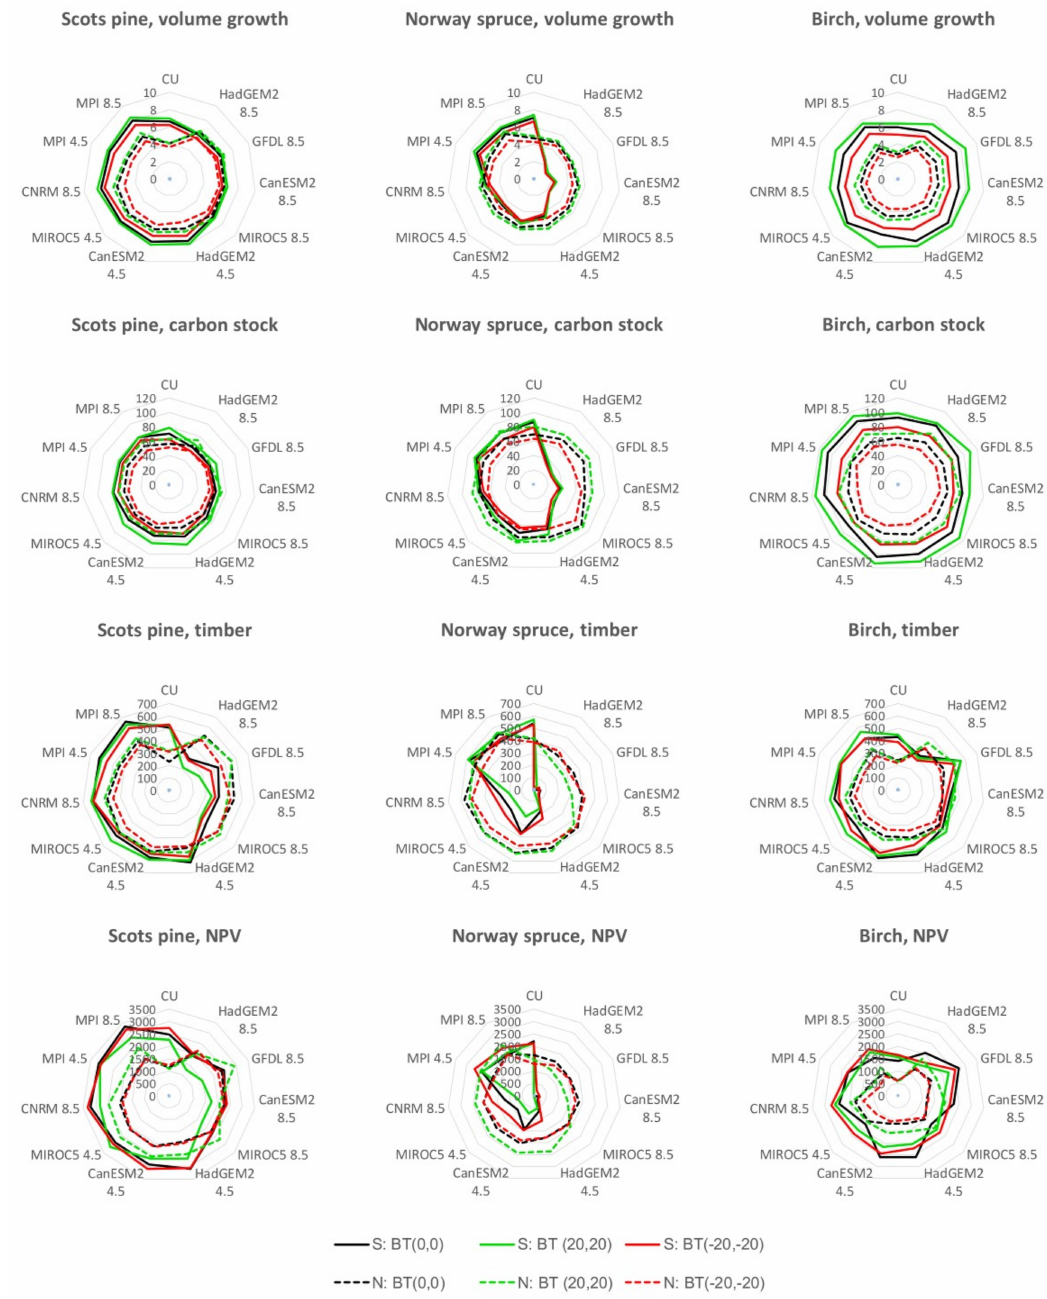
Figure 6. The annual stem volume growth (m 3 ha − 1 year − 1 ), the total ecosystem carbon stock (Mg ha − 1 ), the timber yield (m 3 ha − 1 ) and the NPV ( € ha − 1 ) of Scots pine, Norway spruce and Silver birch stands with different management regimes under the current climate (CU) and individual GCM projections (shown in table 2), under the RCP4.5 and RCP8.5 forcing scenarios, in southern (S) and northern (N)